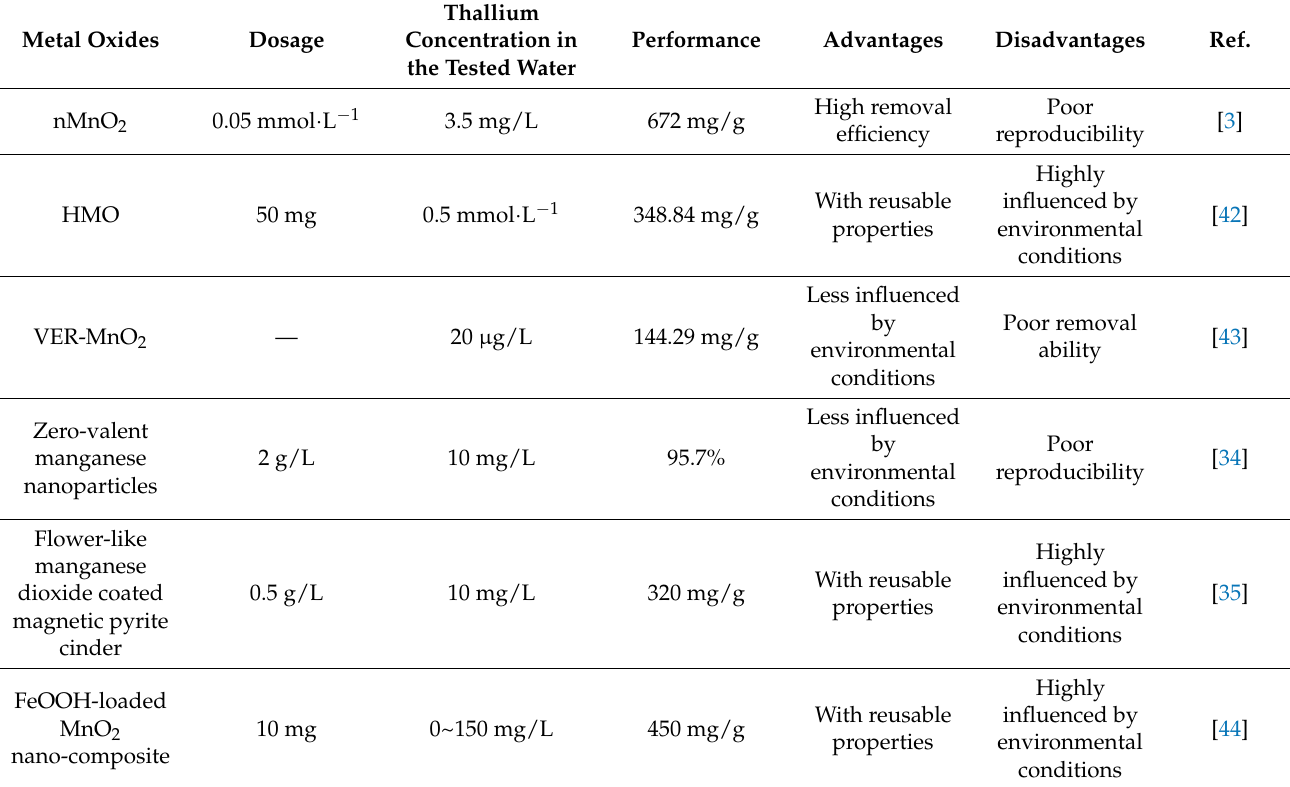
Table 1. Manganese oxide removal thallium performance and advantages and disadvantages.